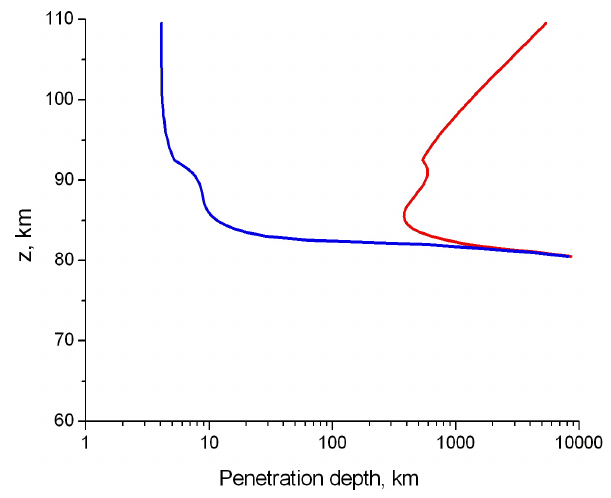
Fig. 5. The penetration depth of the RHP waves (red curve) and of the LHP waves (blue line) at 1600Hz frequency during the night-